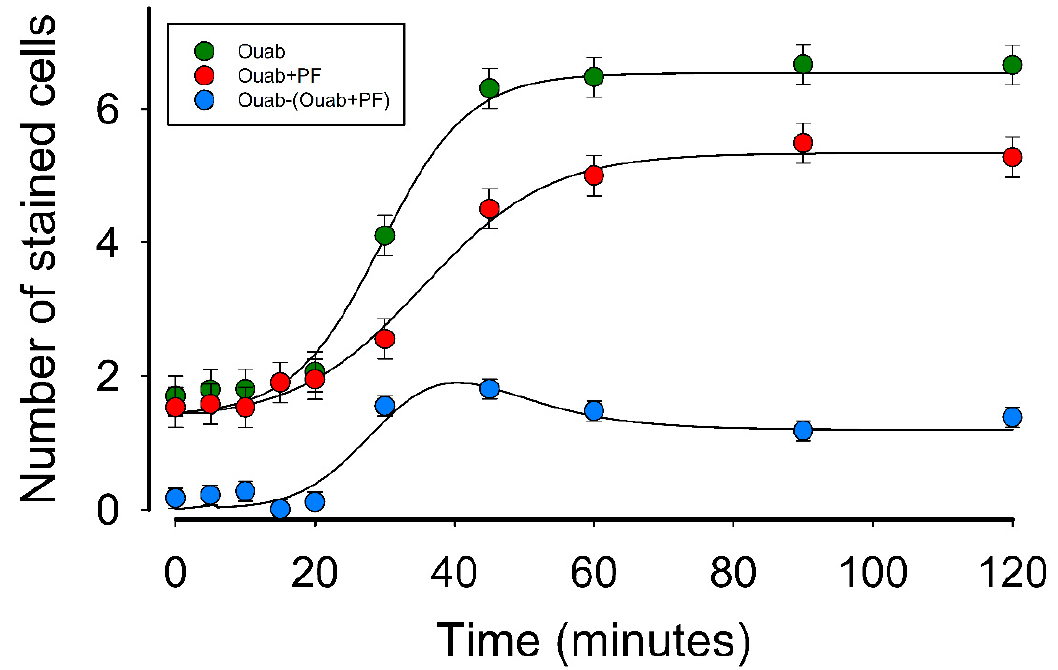
Figure 6. Ouabain induces a synergistic enhancement of GJIC. The plot compares the time course of X SC in MDCK-S cells, induced by treatment with ouabain ( green circles ) or ouabain plus PF-04418948 (PF) ( red circles ) during the various periods of time as plotted. The difference from those two conditions ( blue circles ), can be attributed to PGE2´s contribution. Continuous lines show the best fit of data to a sigmoidal curve after nonlinear regression.